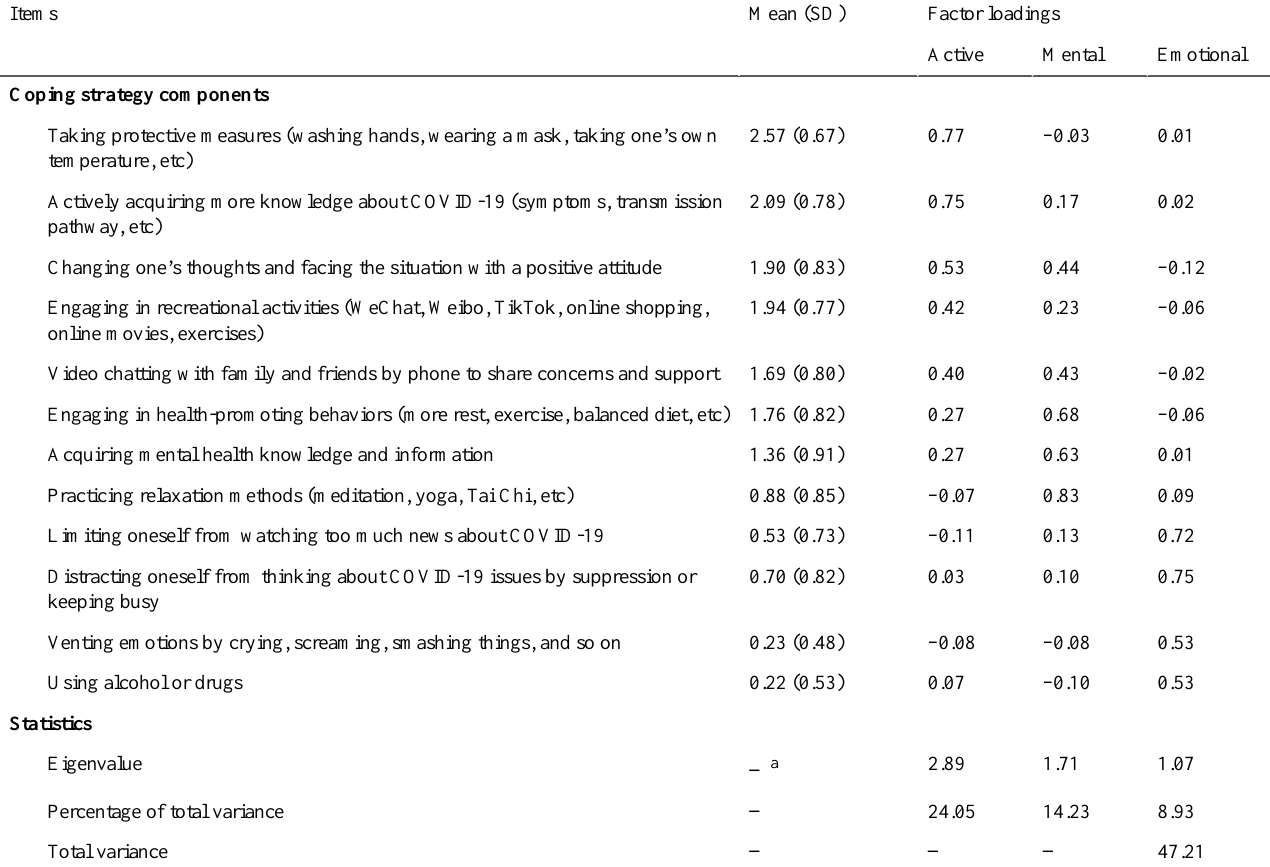
Table 4. Matrix of coping strategy components and three statistics after varimax rotation (the rotation is converged in five iterations; method of extraction: main component